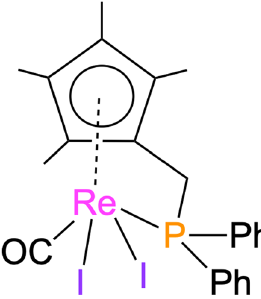
Fig. 2 Diagram of the CSD entry YOXKUS. Diagram of the CSD entry YOXKUS.